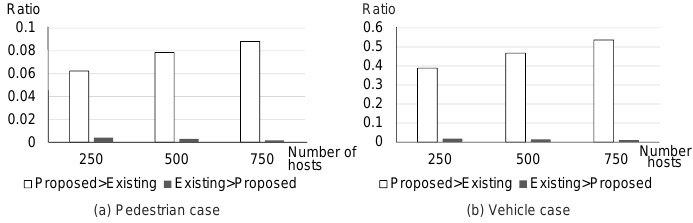
Figure 18. Ratio of the number of different successful bids between the existing method and the proposed method to the 1970 data requests.